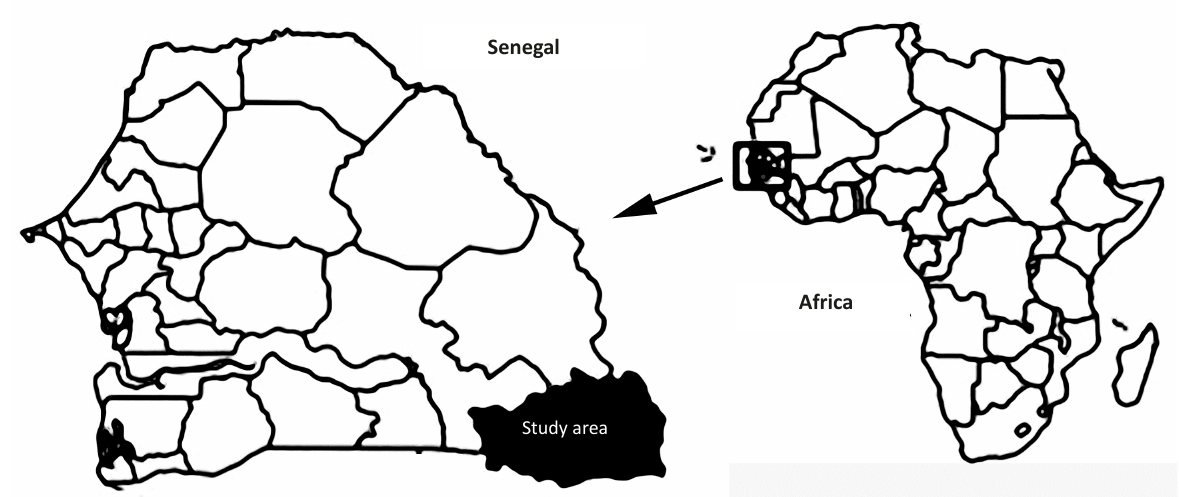
Figure 1. Location of the study area (modified from Ndiaye al. 2013). Detailed location of nests sites is available in Galat-Luong et al. (1999– 2000).